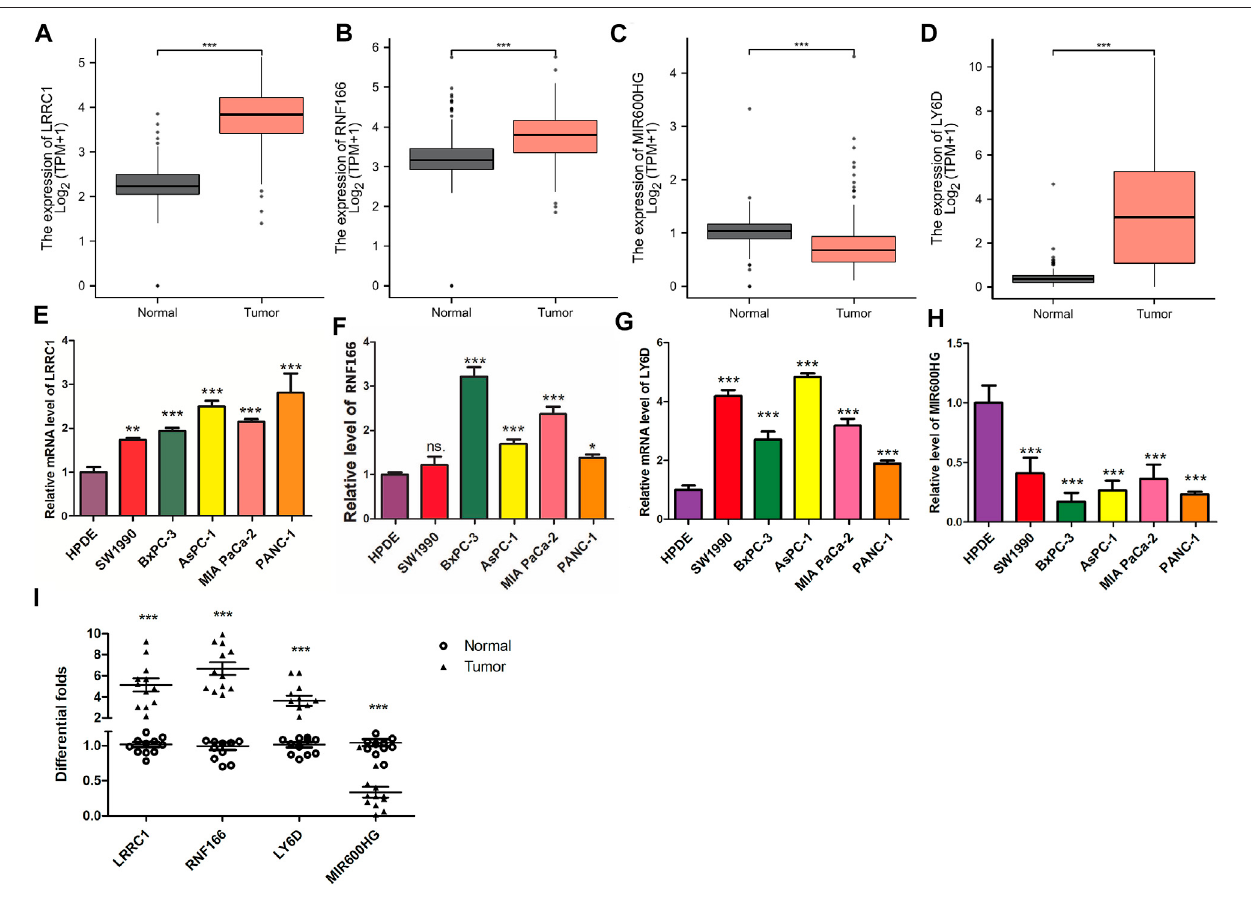
FIGURE 11 | Validation of the expression levels of the four hub genes between normal pancreatic samples and PAAD samples based on TCGA and GTEx data in GEPIA.ExpressionlevelsofLRRC1,RNF166,LY6D,andMIR600HGinnormalpancreaticsamplesandPAADsamples (A – D) .RT-qPCRwasappliedtotestLRRC1 (E) , RNF166 (F) ,LY6D (G) ,andMIR600HG (H) expressionsinPCcelllines.Validationoftheexpressionlevelsofthefourhubgenesbetweennormalpancreatic samples( n (cid:1) 12) and PAAD samples ( n (cid:1) 12) by PCR analysis (I) . All of the data are presented as mean ± SD. Signi fi cant differences are de fi ned by a p value <